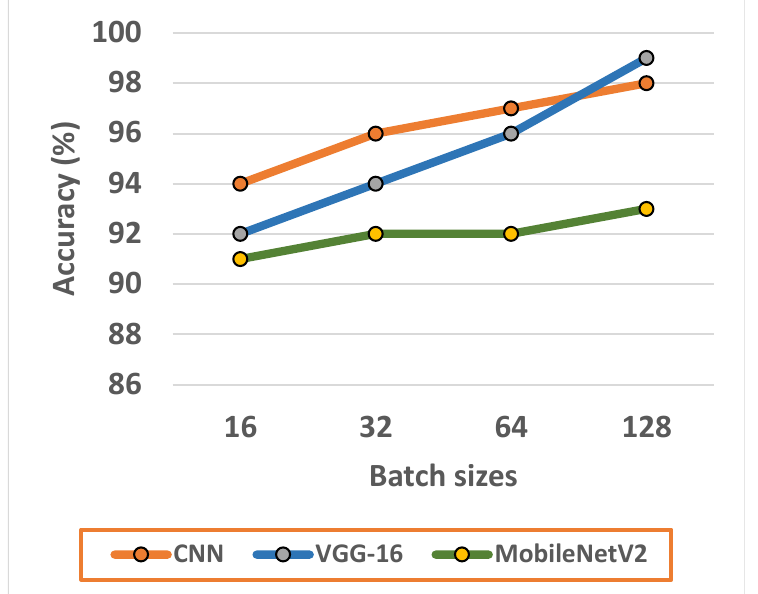
Figure 18. Testing accuracies of the soft rot with variant batch